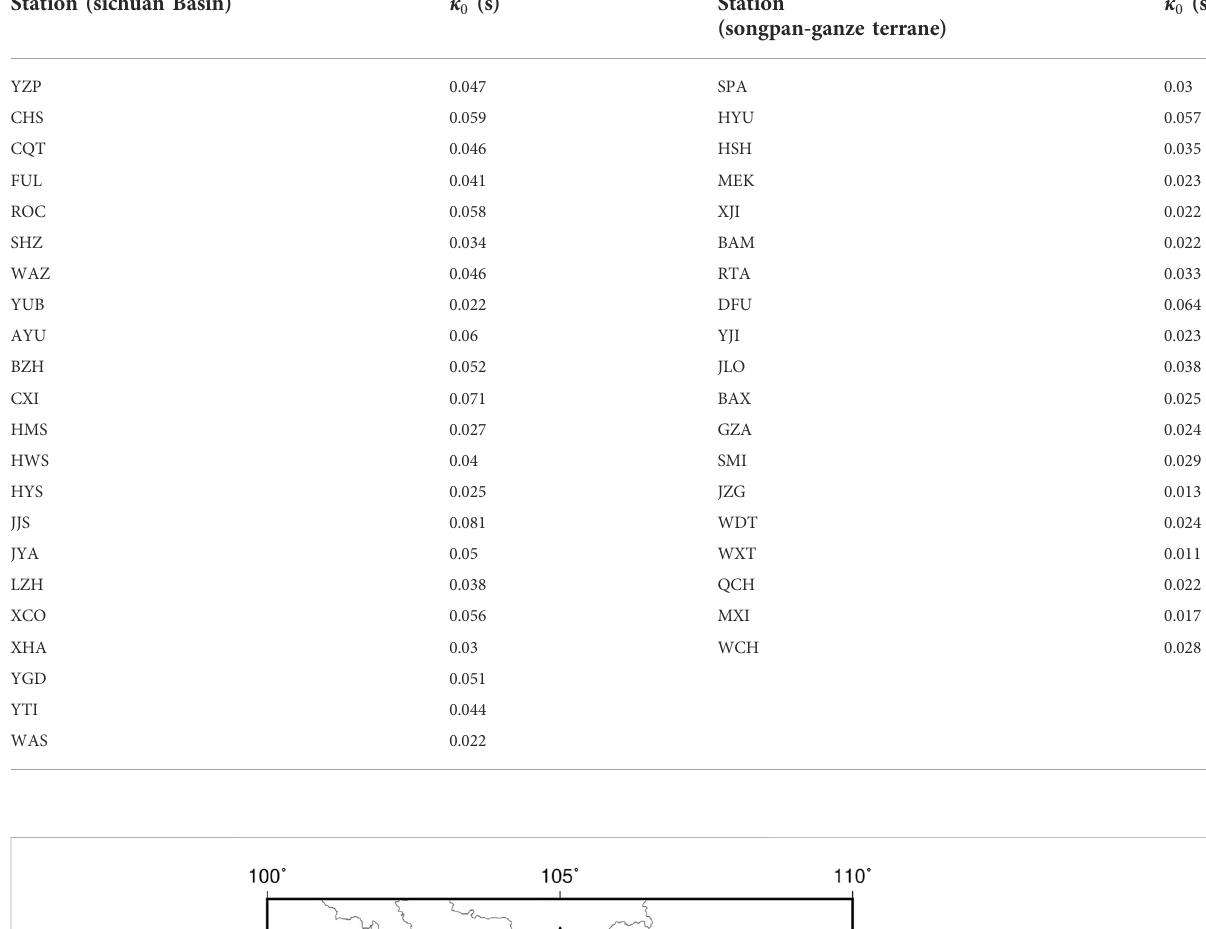
TABLE 1 Kappa ( κ 0 ) estimates from Lg Fourier spectral amplitudes of stations in the Sichuan Basin and Songpan-Ganze terrane. Station (sichuan Basin)